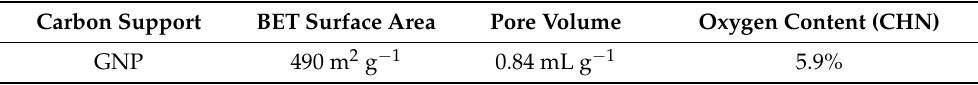
Table 1. Characterization of the carbon support.